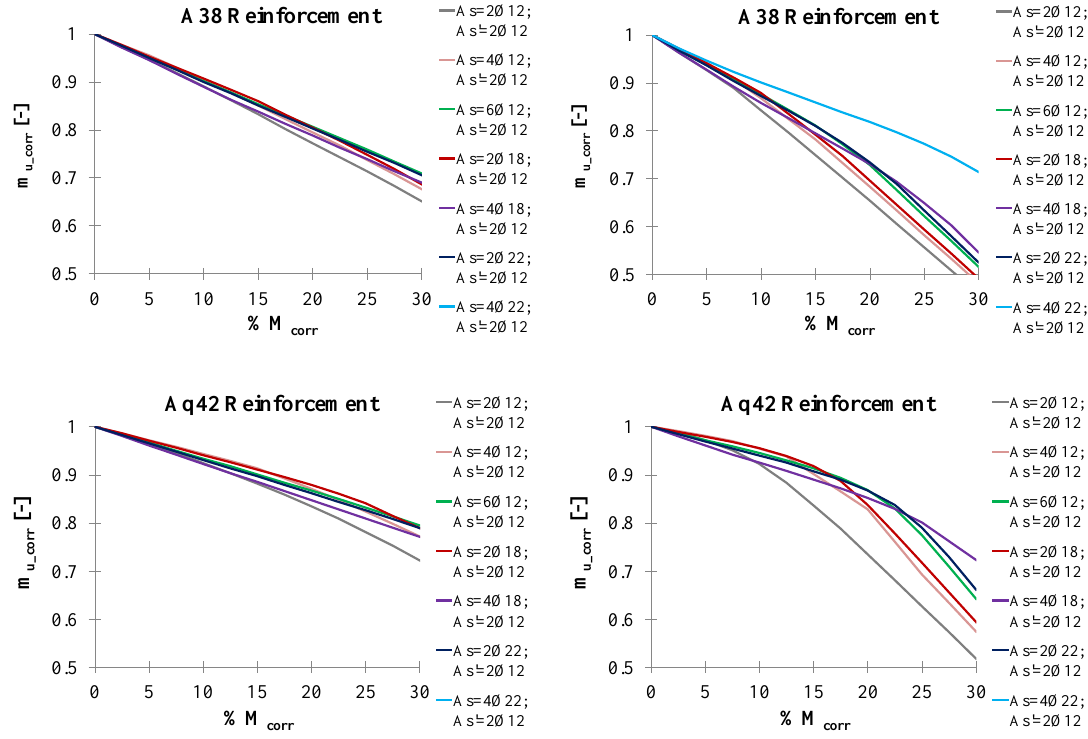
Figure 11. Nondimensional ultimate bending moment for existing formed beams: on the left the case of the uniform corrosion, on the right the pitting corrosion.